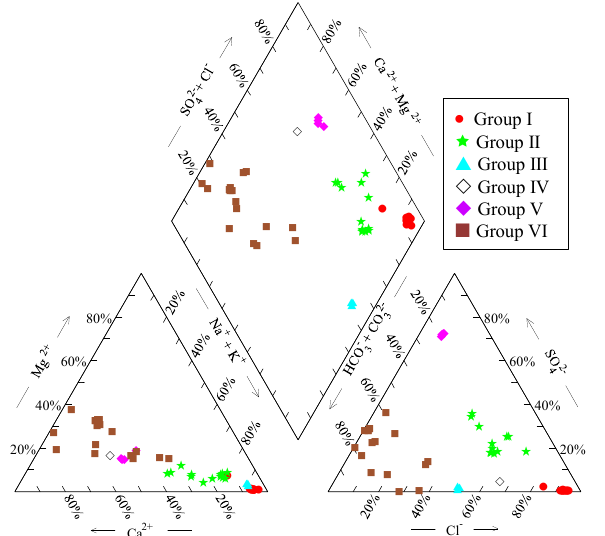
Figure 2. Reported chemistry of waters measured from several hot/warm springs and wells located in southeastern